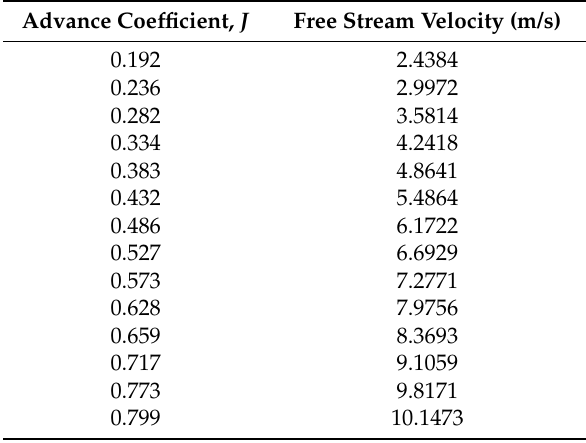
Table 1. Simulation flow